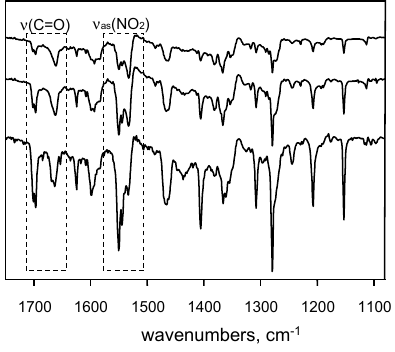
Figure 14. Spectrum of 5-methyl-3-nitro-2-hydroxyacetophenone ( 11 ) in argon matrix condition in the function of sublimation. Reprinted with permission from [91]. Copyright 2008 Elsevier.